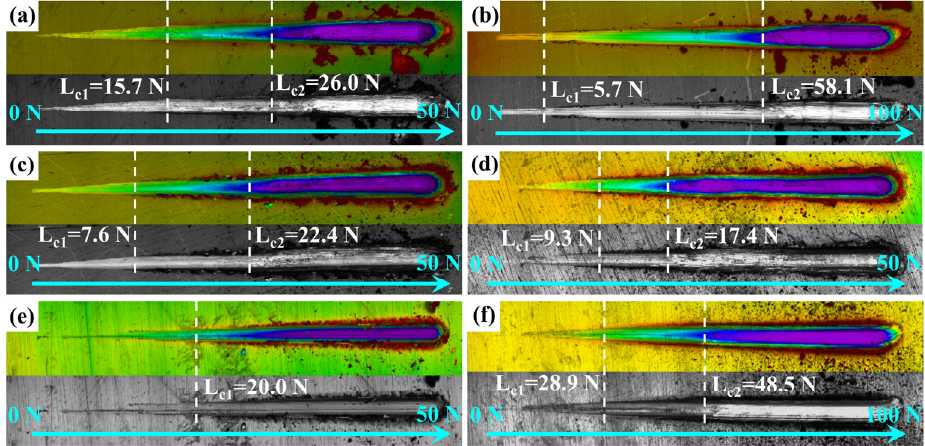
Figure 10. The images of the scratch of ( a ) TiCrN, ( b ) TM0, ( c ) TM1, ( d ) TM2, ( e ) TM3, and ( f ) TM4 coatings.